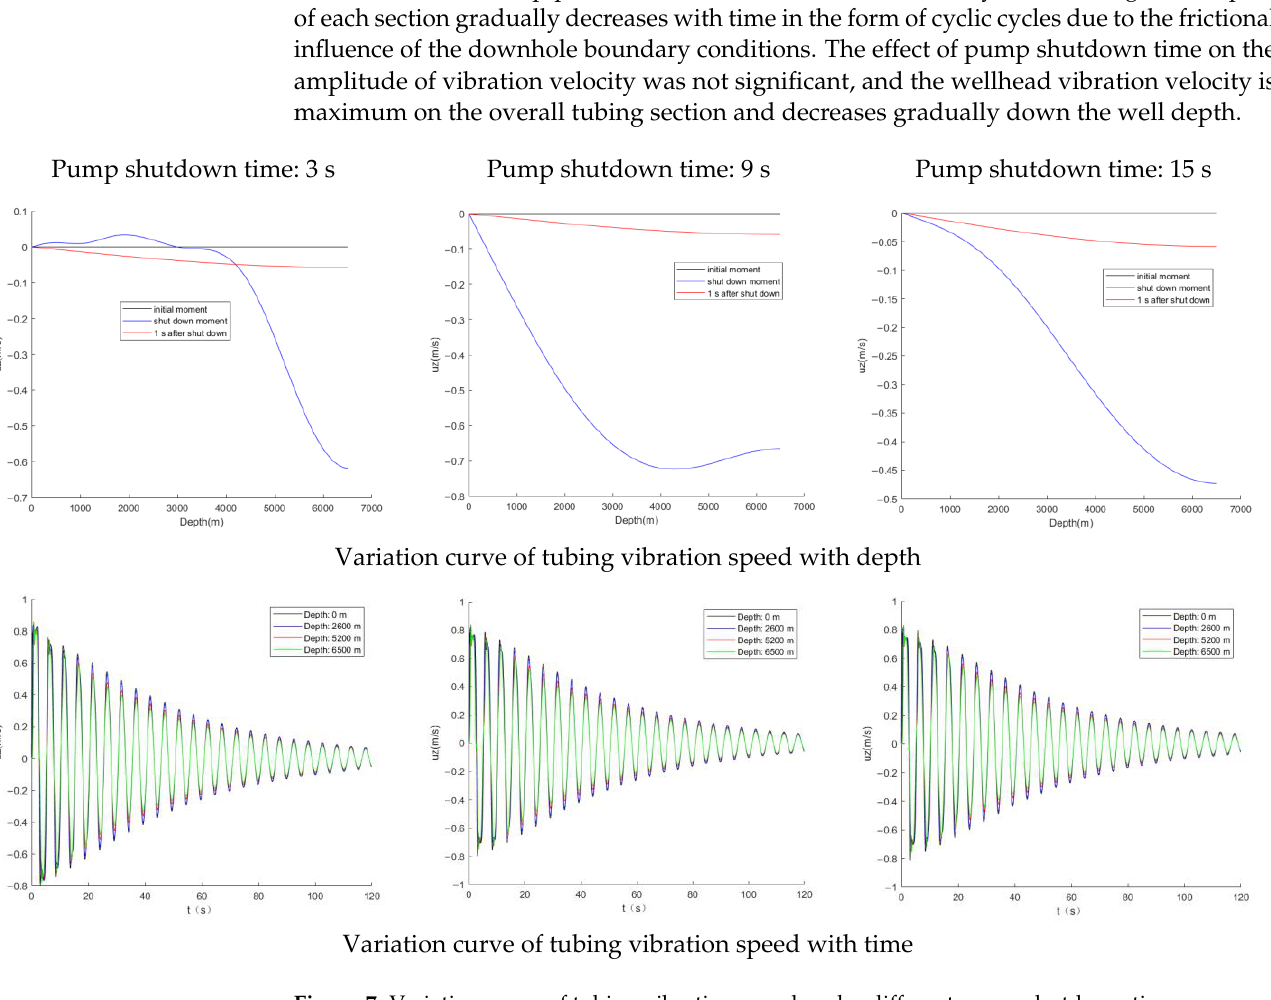
Figure 7. Variation curve of tubing vibration speed under different pump shutdown time.